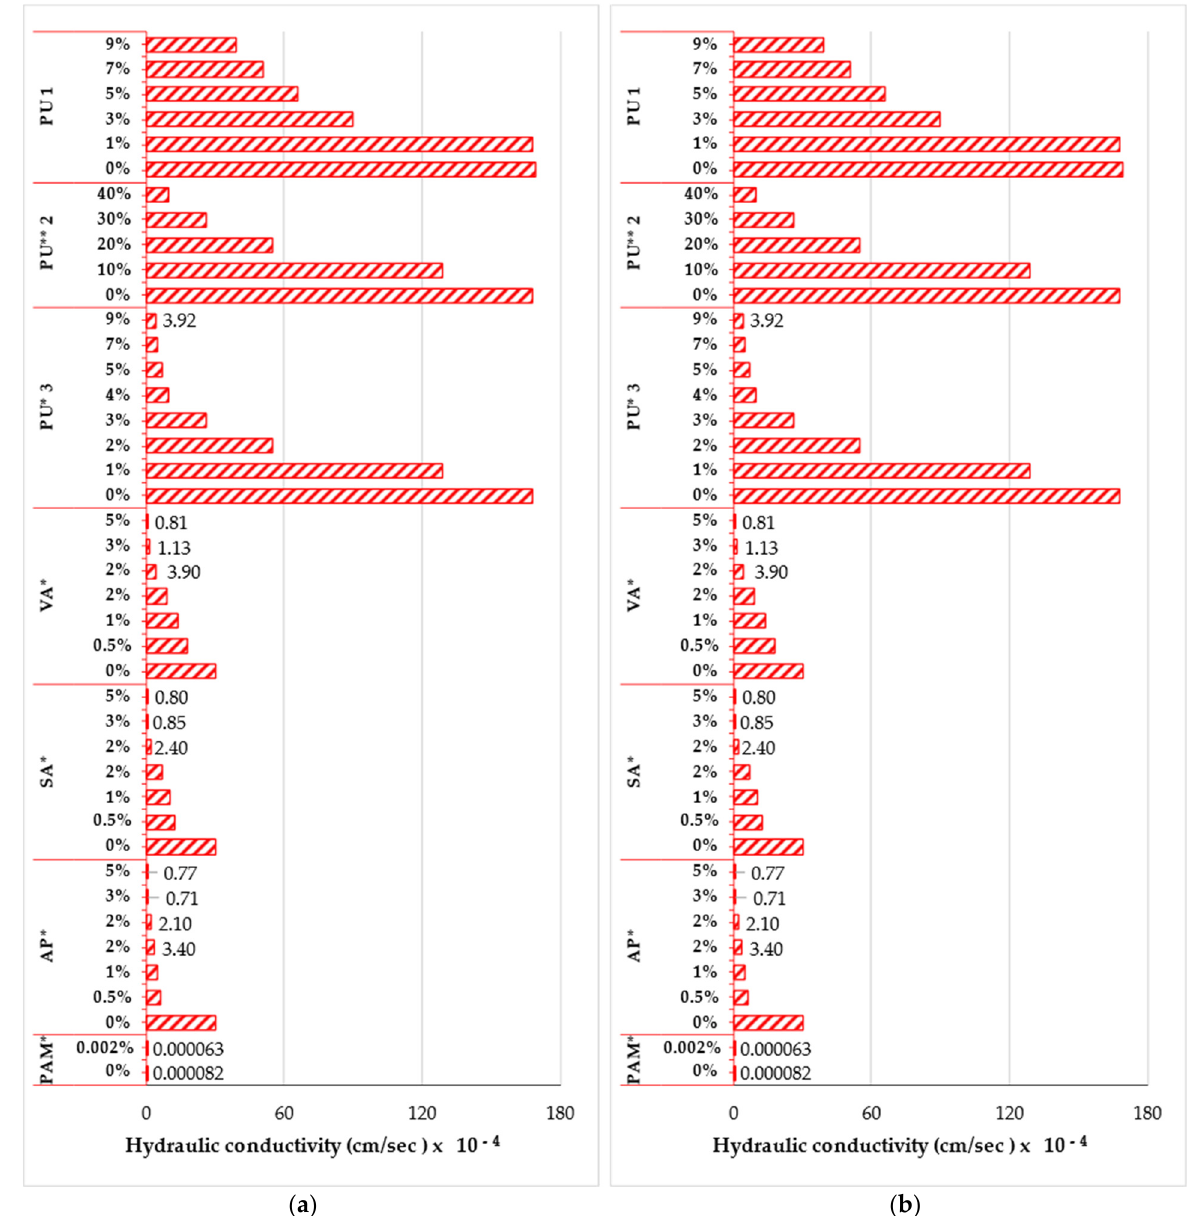
Figure 9. Variation of hydraulic conductivity with polymer concentration for: ( a ) Fine-grain soil; ( b ) Cohesionless soil (* indicates polymer concentration as a % of dry weight of soil and ** as a % of weight of water). Note: